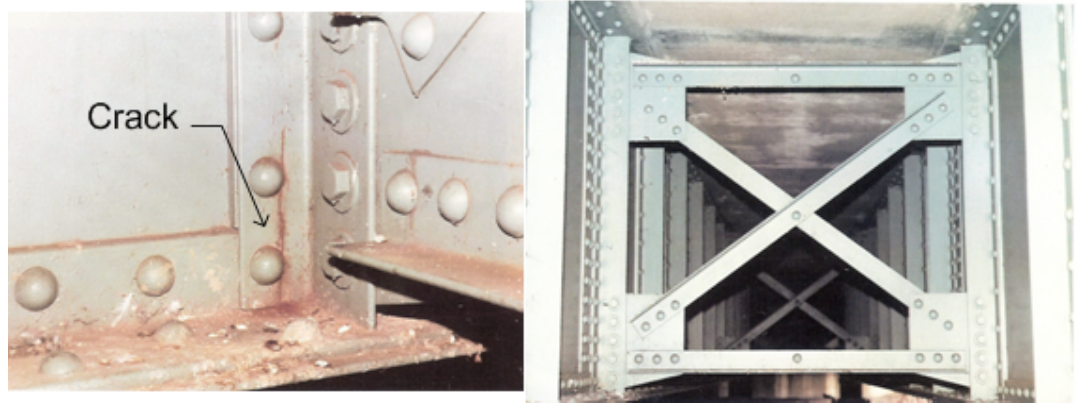
Figure 13. Fatigue cracking in the riveted connection of cross-bracing elements